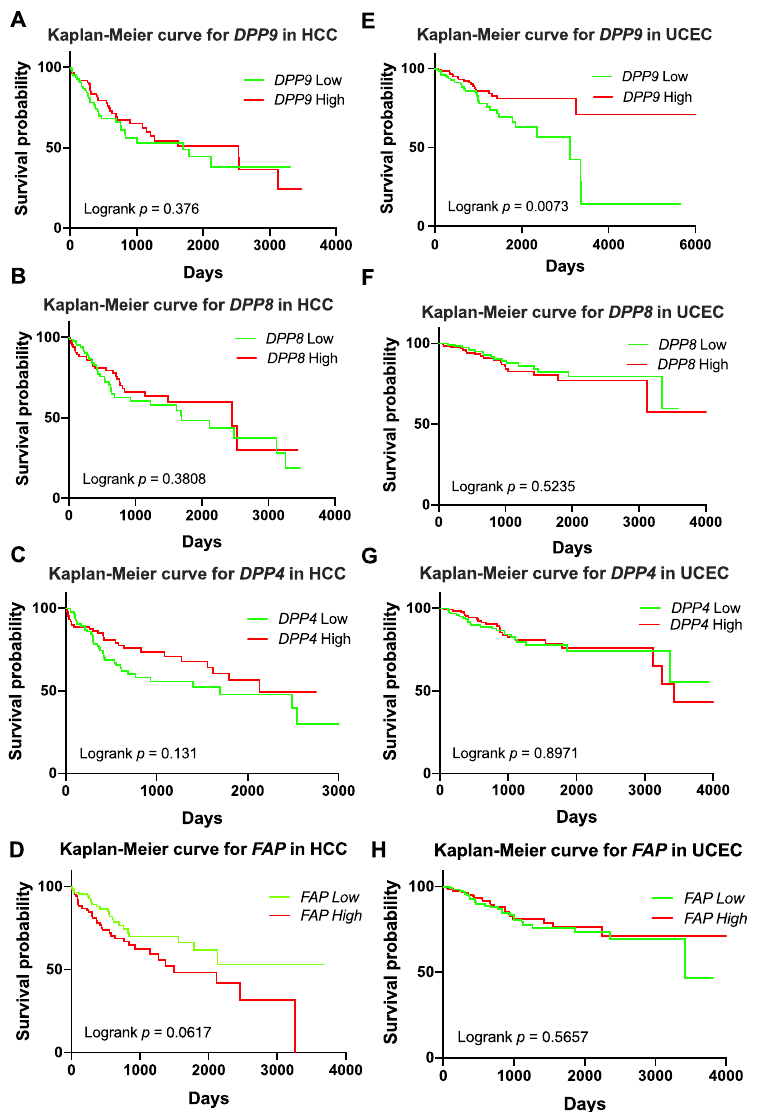
Figure 1. Kaplan-Meier curves for DPP9, DPP8, DPP4 and FAP in liver tumors (hepatocellular carcinoma, HCC; ( A – D )) ( n = 360) and uterine corpus endometrial carcinoma (UCEC; ( E – H )) ( n = 540). High or low was defined as the mRNA expression values in the upper or lower quartile, respectively. p values were calculated by logrank (Mantel-Cox) test.